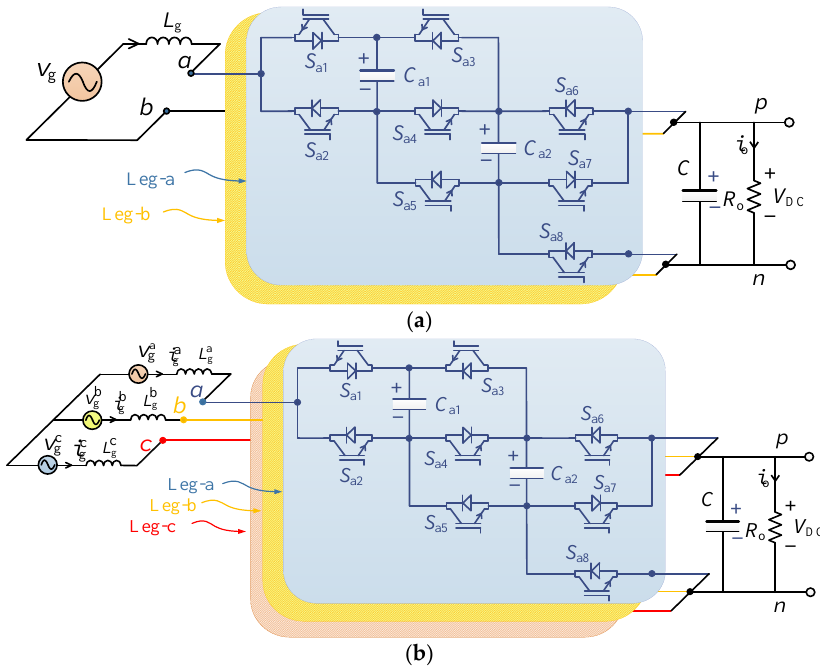
Figure 4. Proposed PFC rectifier topology with the capability of bidirectional power flow ( a ) Single- phase, ( b ) Three-phase.